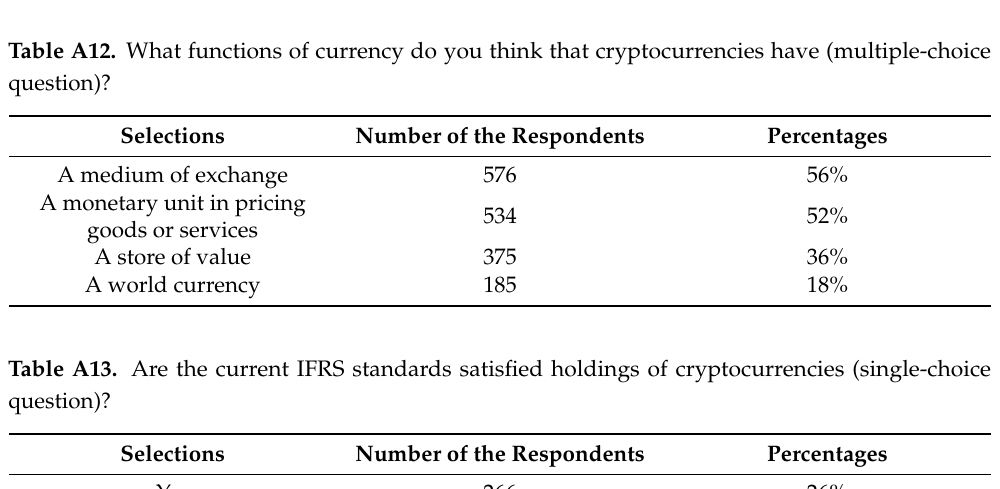
Table A11. Do you think that cryptocurrencies are cash or non-cash currency (single-choice question)? Selections